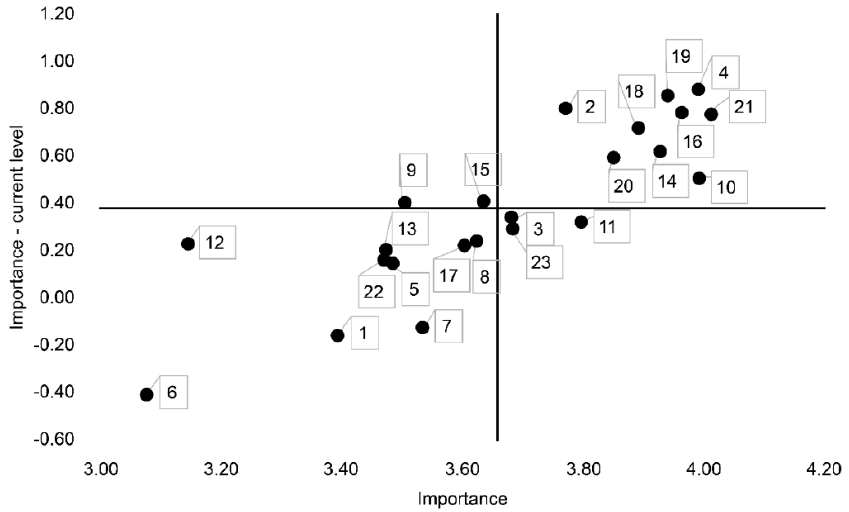
Figure 3. Results of the Locus for Focus analysis for 4-year university students.